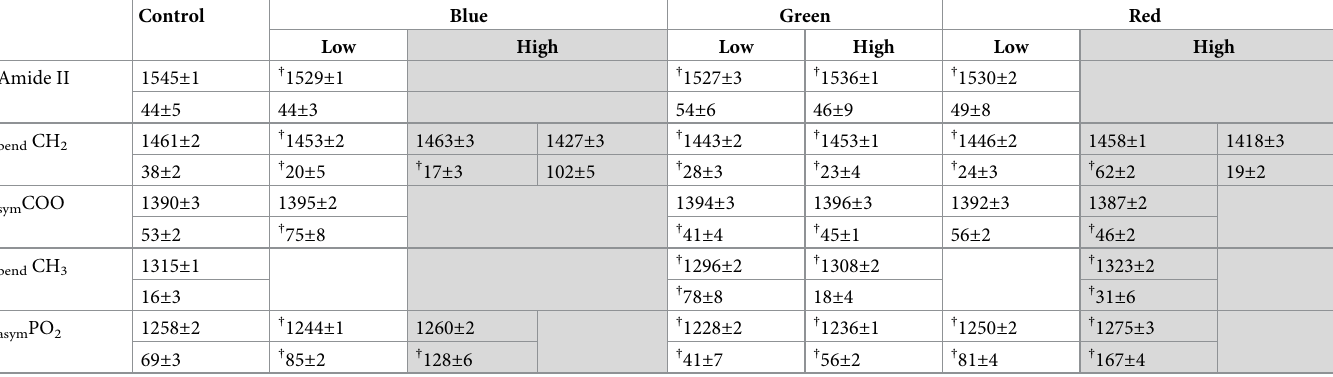
Table 4. Fingerprint region showing the bending modes of different bands and their characteristic vibrational frequency (cm -1 ) and bandwidth (cm -1 ).